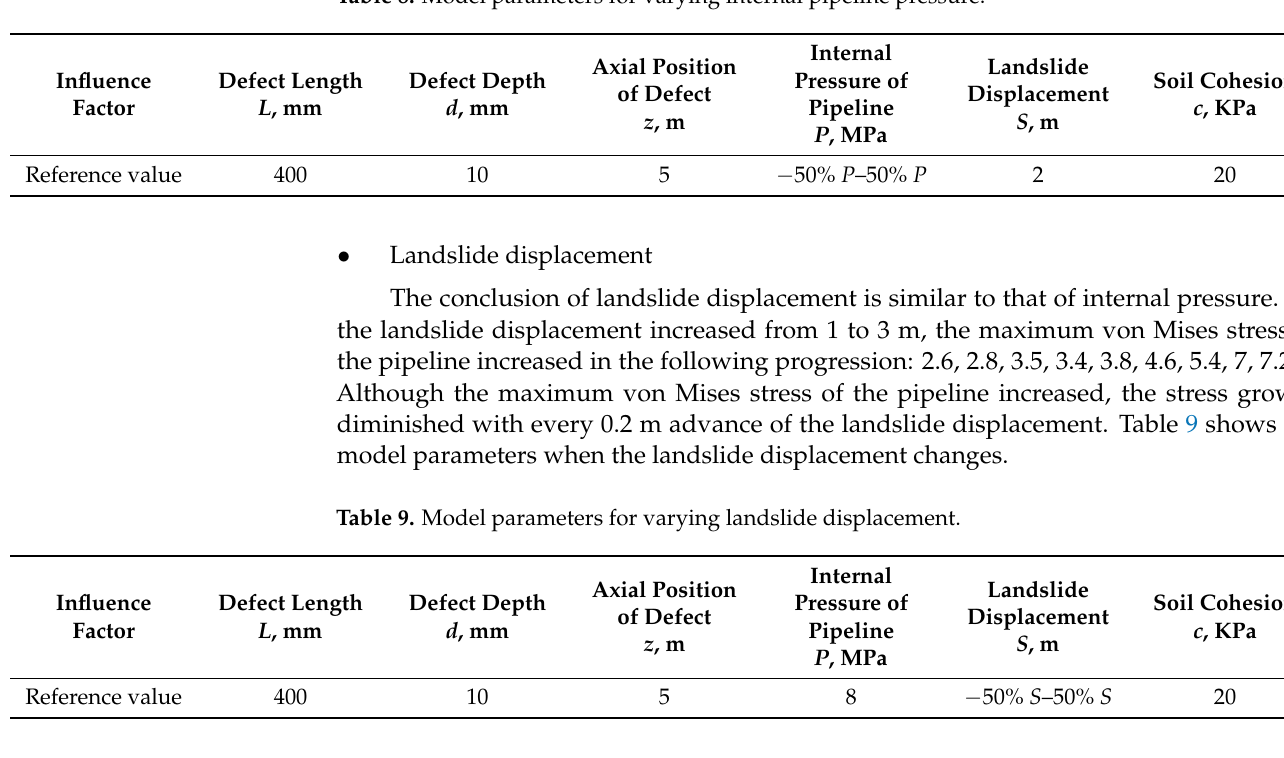
Table 8. Model parameters for varying internal pipeline pressure.